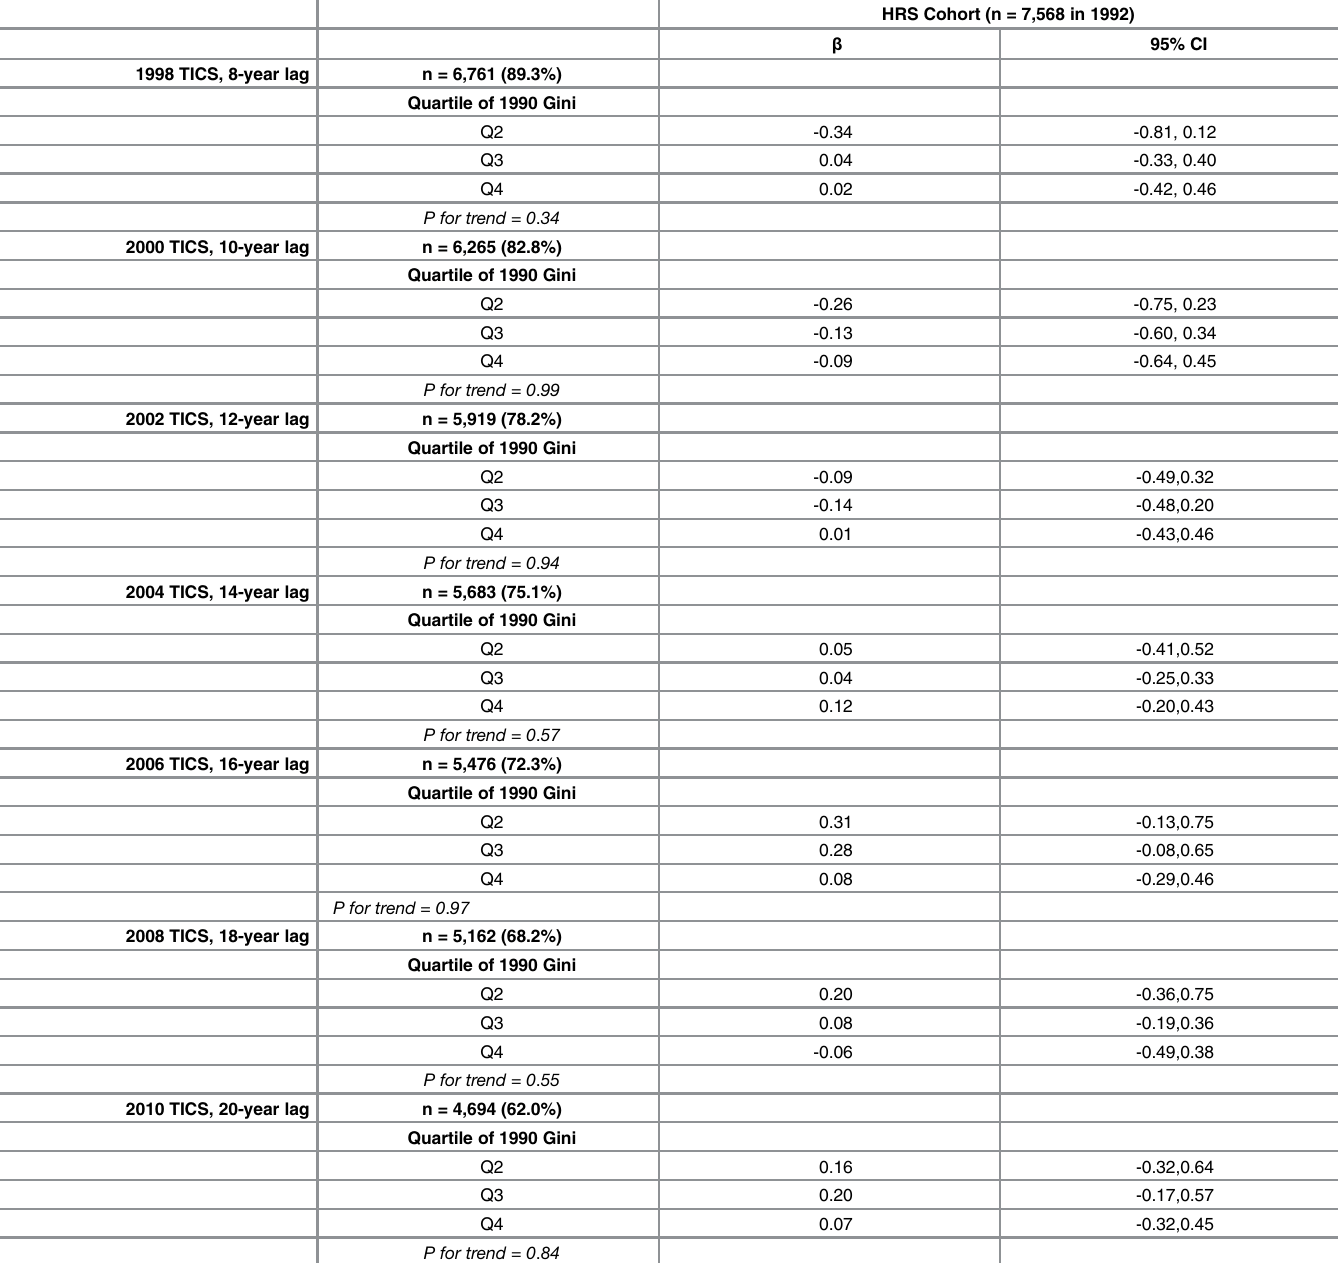
Table 3. Non-response weighted multivariate linear regression coefficient estimates with varying lag periods between the 1990 U.S. state-level Gini coefficient and TICS-m score (1998 – 2010), Health and Retirement